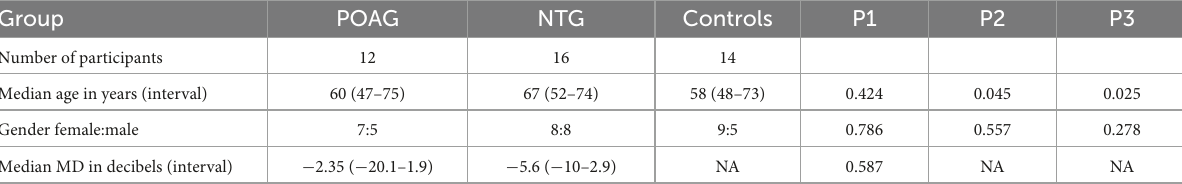
TABLE 1 Descriptive statistics of the analyzed study